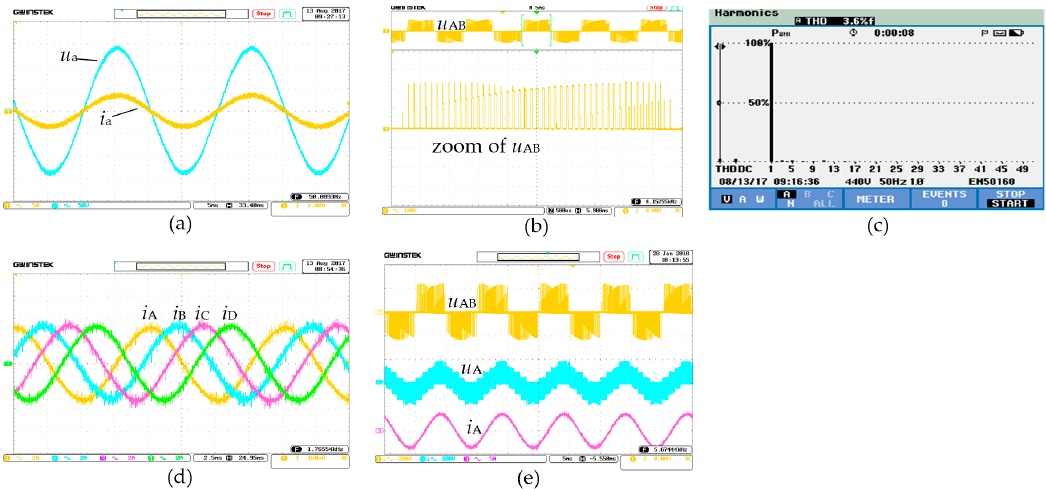
Figure 8. Experimental waveforms with U in = 100 Vrms, f out = 100 Hz, and q = 0.5: ( a ) input voltage u a and input current i a ; ( b ) output line ‐ to ‐ line voltage u AB and zoom of u AB ; ( c ) the FFT analysis of the u AB ; ( d ) output currents i A , i B , i C , i D ; ( e ) output line ‐ to ‐ line voltage u AB , output phase voltage u A , and output phase current i A .